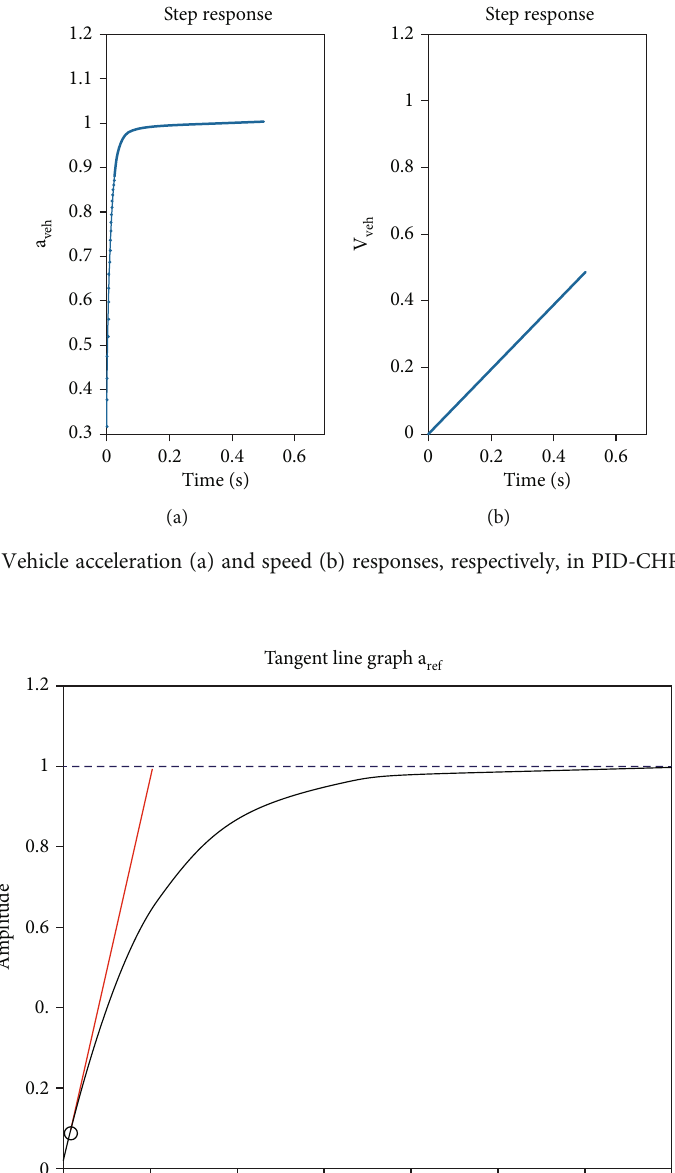
tangent line in closed-loop PID-CC ref